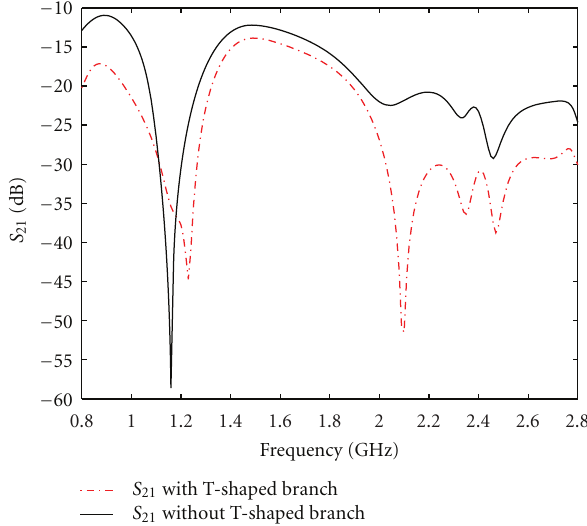
Figure 12: Simulated results of S 21 of the antenna with the T-shaped branch or